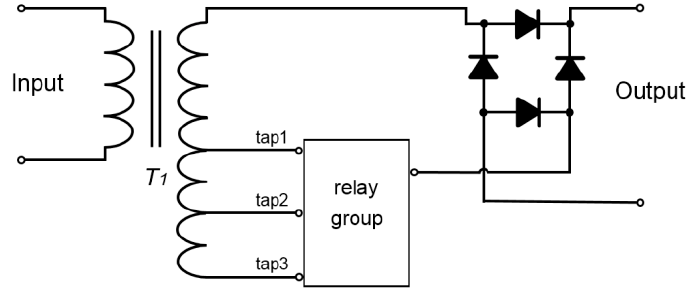
Figure 7. The design to adjust the turn ratio of the transformer of the proposed converter.